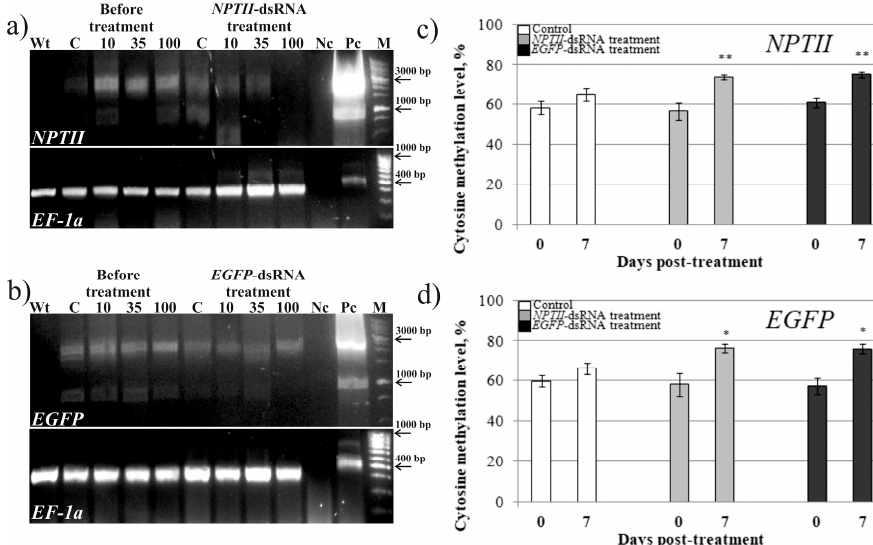
Figure 6. Detection of the read-through transcripts, including both the EGFP and NPTII sequences, and analysis of the total cytosine DNA methylation, within the NPTII and EGFP transgenes in the transgenic L1 line of A. thaliana, before and 7 days after foliar application of dsRNAs or filtered sterile water. ( a , b ) Agarose gel electrophoresis of the RT-PCR products. C—control treatment (sterile filtered water). 10, 35, 100—treatment with the dsRNAs diluted in water to concentrations of 0.1, 0.35, and 1 µ g/ µ L (100 µ L per plant). M—low molecular weight DNA ladder; Nc—negative control (RT-PCR mixture without RNA); Pc—positive control (pZP-RCS2 plasmid). ( c , d ) Bisulfite sequencing of the DNA purified from the dsRNA- and water-treated plants. The dsRNAs were